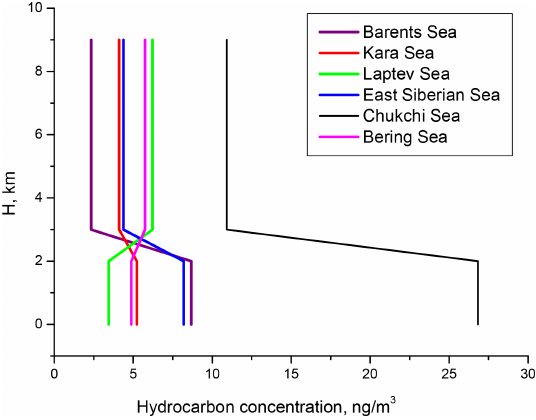
Figure 16. The total concentration of normal hydrocarbons in the air.